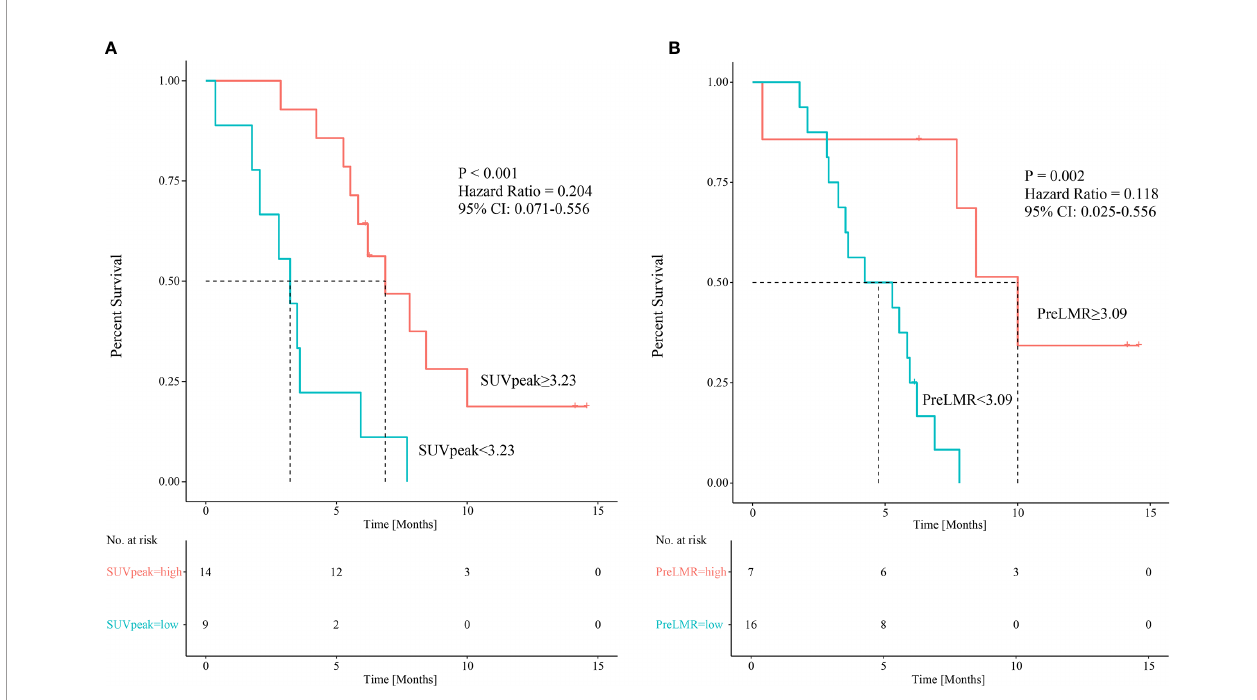
FIGURE 4 | Kaplan-Meier curves showing patients ’ PFS among patients with different SUVpeak (A) and PreLMR levels (B) .